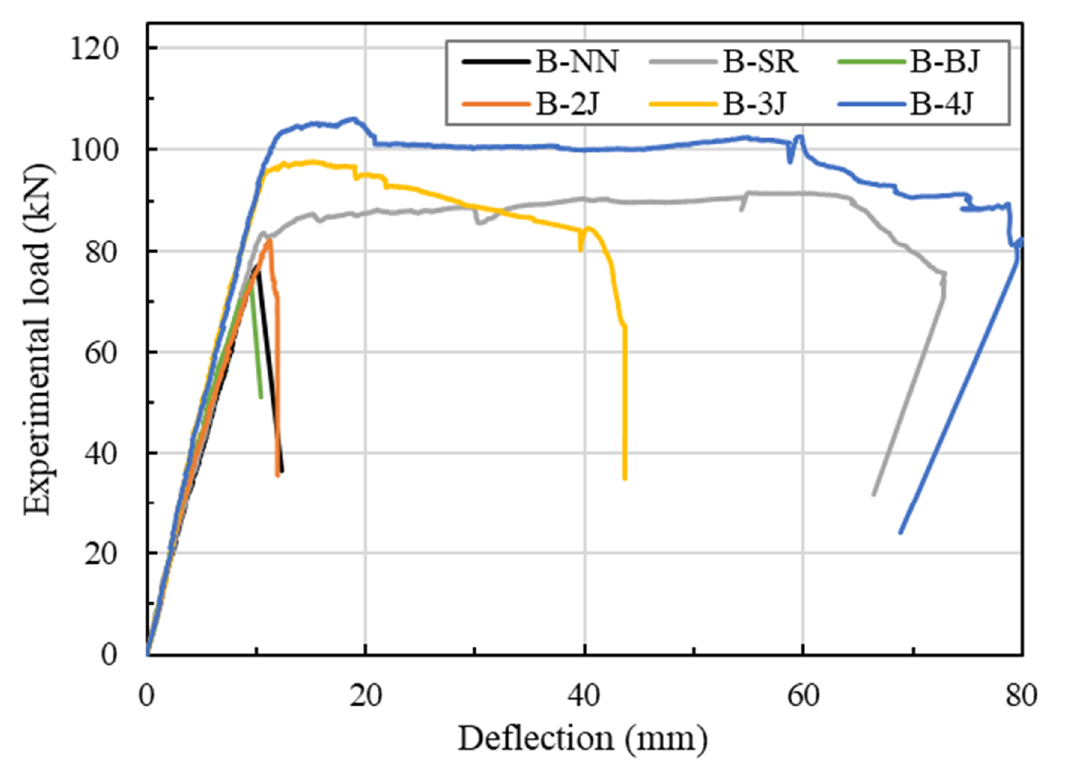
Figure 8. Load–deflection curves of test beams. Table 8. Test results of beams.